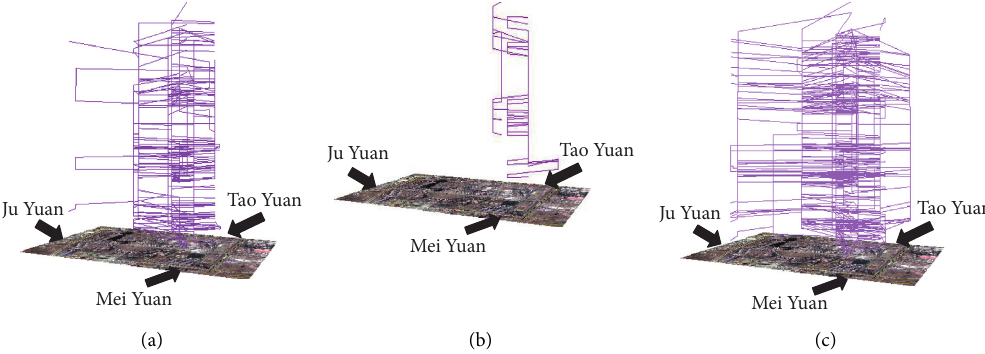
Figure 13: Weekend activities travel pattern classification. (a) Classroom+library, (b) canteen, and (c)